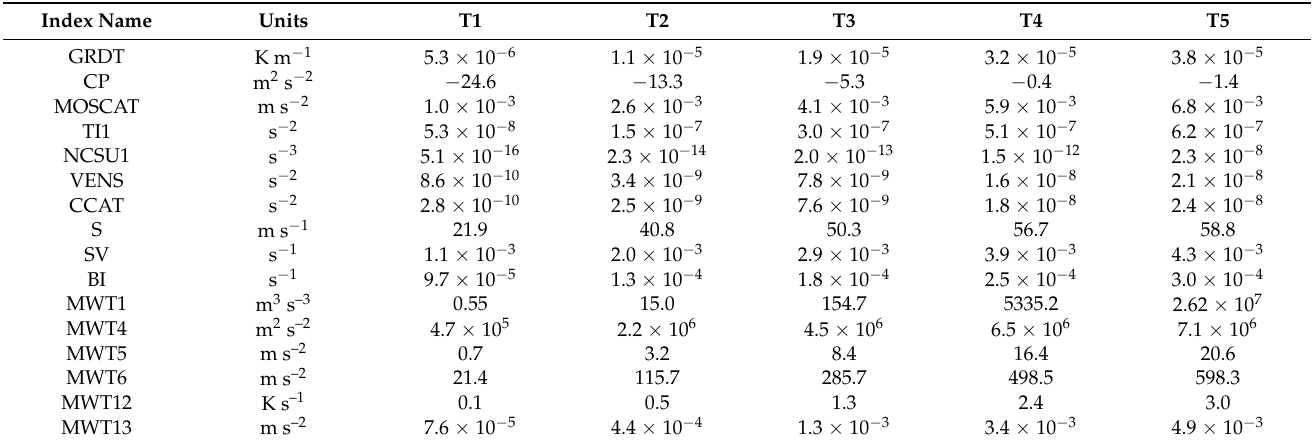
Table 2. Thresholds (T1, T2, T3, T4, and T5) corresponding to light, light–moderate, moderate, moderate–severe, and severe turbulence categories for individual diagnostics according to the per- centile in Table